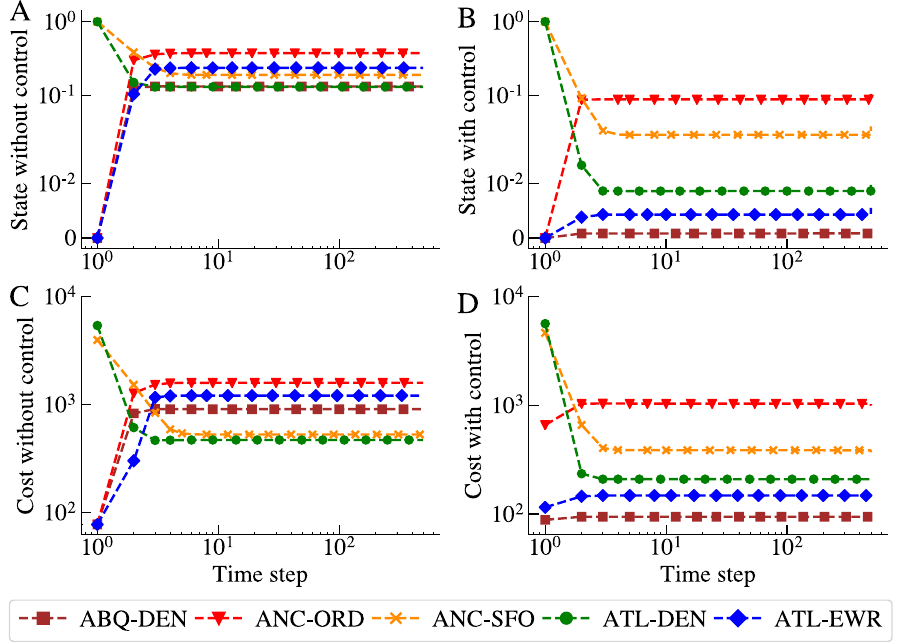
Figure 2. State and cost trajectories of five representative flights by United Airlines. ( A, C ) The state and cost trajectories of flights without control. ( B, D ) The state and cost trajectories of flights under LQR